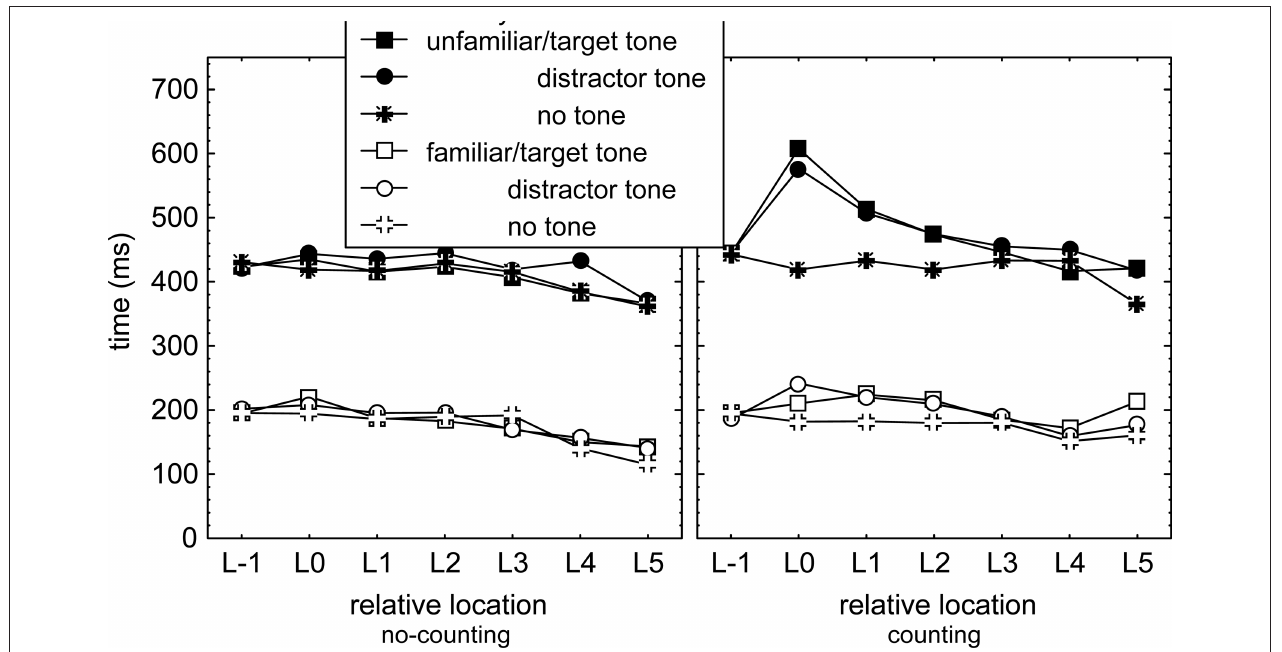
Figure 3 | response times as a function of location relative to tone presentation (L interval immediately following the tone, and so on), tone identity, sequence familiarity, counting condition, and secondary